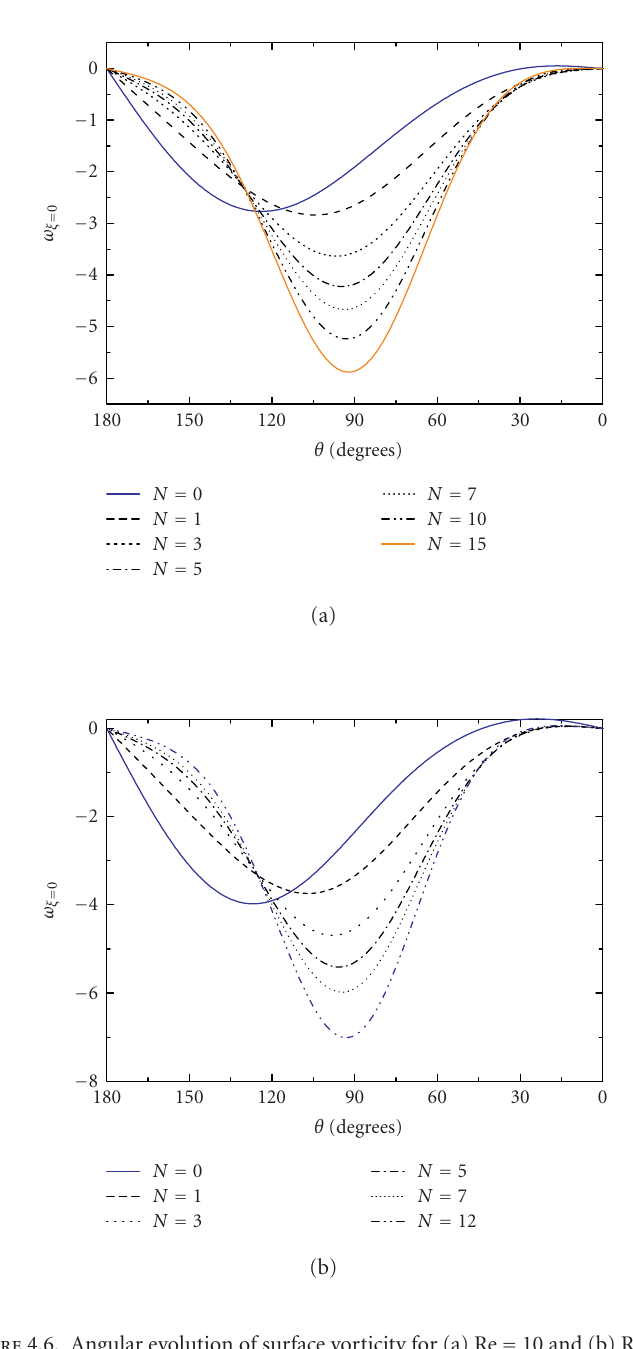
Figure 4.6 . Angular evolution of surface vorticity for (a) Re = 10 and (b) Re =